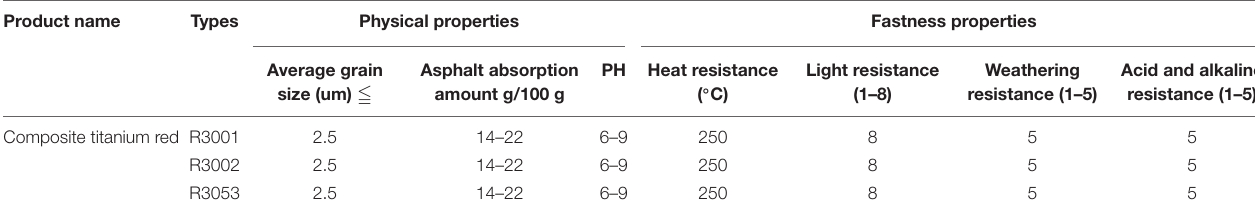
TABLE 3 | Technical indexes of the composite titanium red pigment technique.